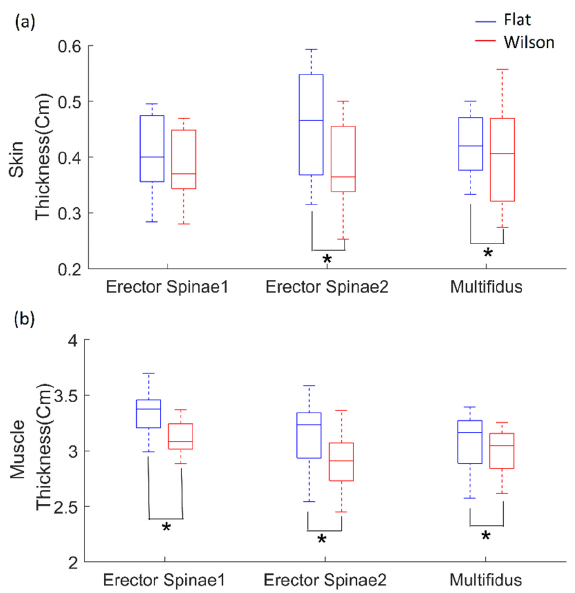
Figure 6. ( a ) Skin thickness in sites used to measure erector spinae 1 and 2, and multifidus; ( b ) muscle thickness based on flat (blue) and Wilson (red) table postures. Each box plot indicates 25th (Q1), 50th (Q2), and 75th (Q3) data percentiles. Whisker indicates Q3 + 1.5 × (Q3 – Q1) and Q1 − 1.5 × (Q3 – Q1). *, p < 0.05.